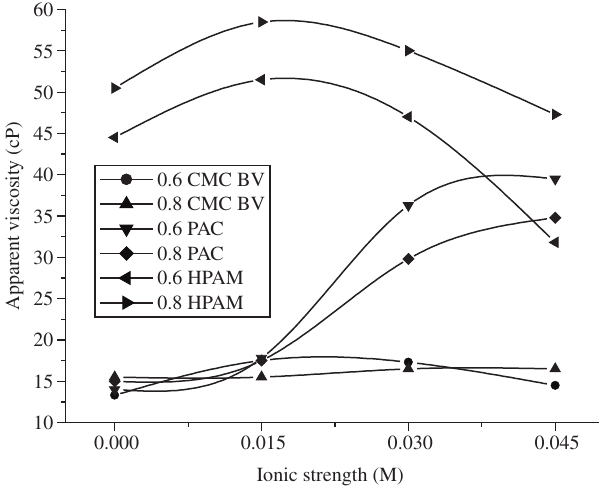
Figure 1. Influence of ionic strength on the apparent viscosity of bentonite suspensions treated with